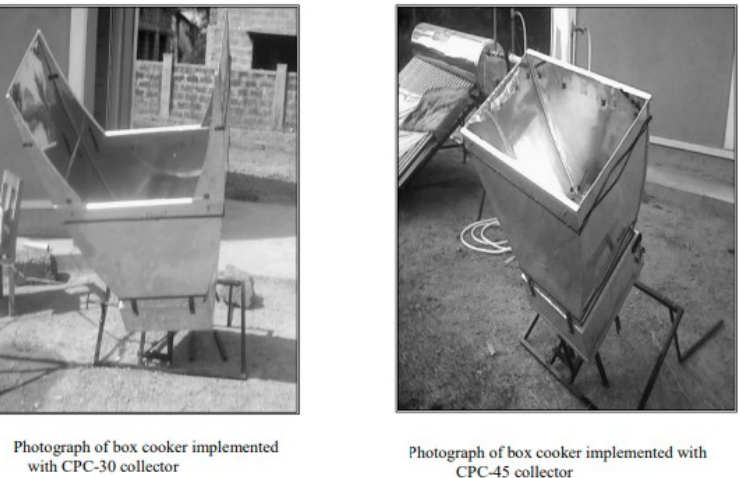
Figure 15. Box cooker with CPC Concentrator. Reprinted/adapted with permission from Ref. [43], 2020, AIP Publishing.